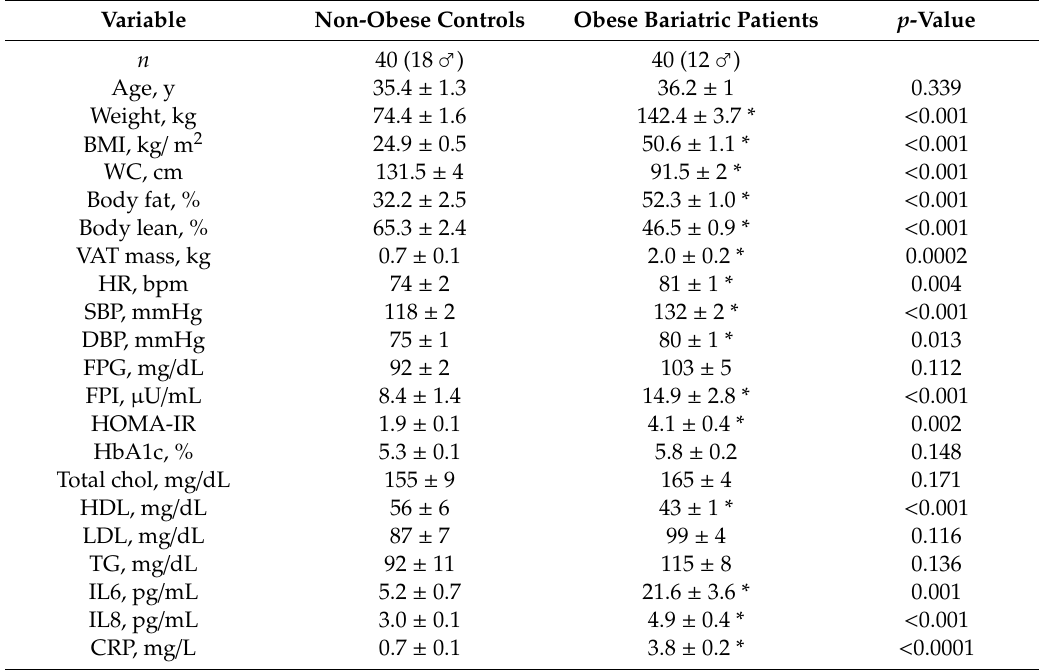
Table 1. Physical characteristics Cardiometabolic risk factors of study